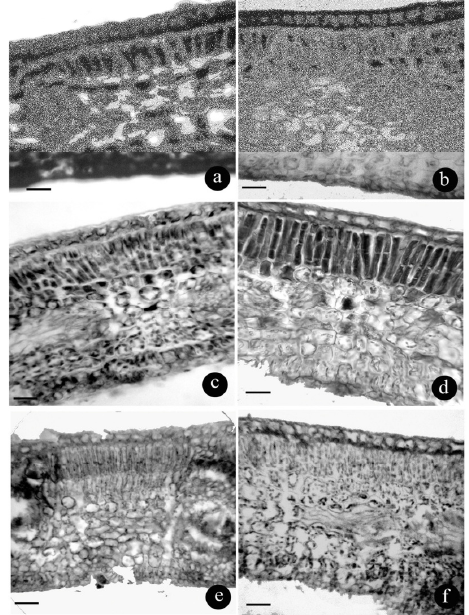
Fig. 4. Anatomical features of the leaf lamina in M. indica varieties, magnification bar, a to f – 10 mm a. ‘Badshahpasand’- single layered pallisade, spongy layer cells compactly arranged b. ‘Desi’- single layered pallisade, spongy layer cells compactly arranged; c. ‘Dudhpendo’- 2 pallisade layers, spongy layer cells loosely arranged; d. ‘Alphonso’- 3 pallisade layers, spongy layer cells compactly arranged; e. ‘Rajapuri’- 2 pallisade layer, spongy layer cells loosely arranged; f. ‘Fazli’- 2 pallisade layer, spongy layer cells loosely arranged